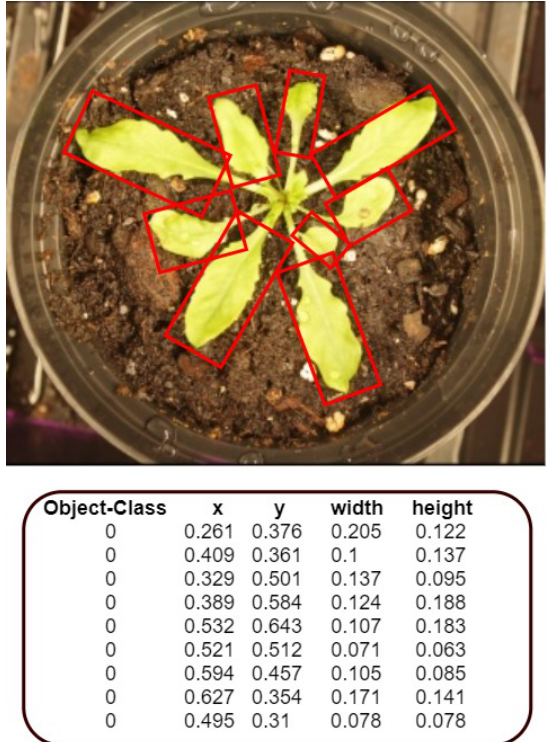
Figure 5. One sample of plant and its annotation from our generated